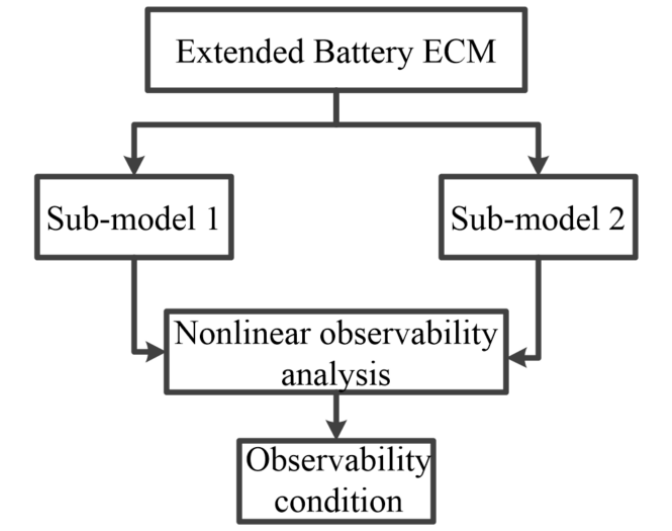
Figure 4. Schematic diagram of the analysis